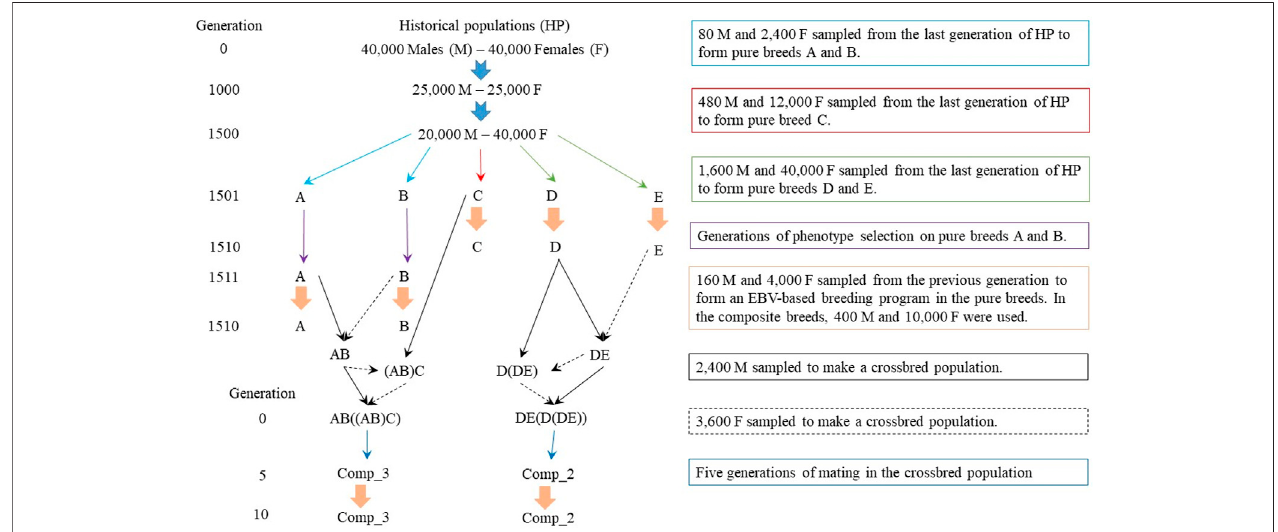
FIGURE 1 | Simulation design to obtain pure and composite sheep